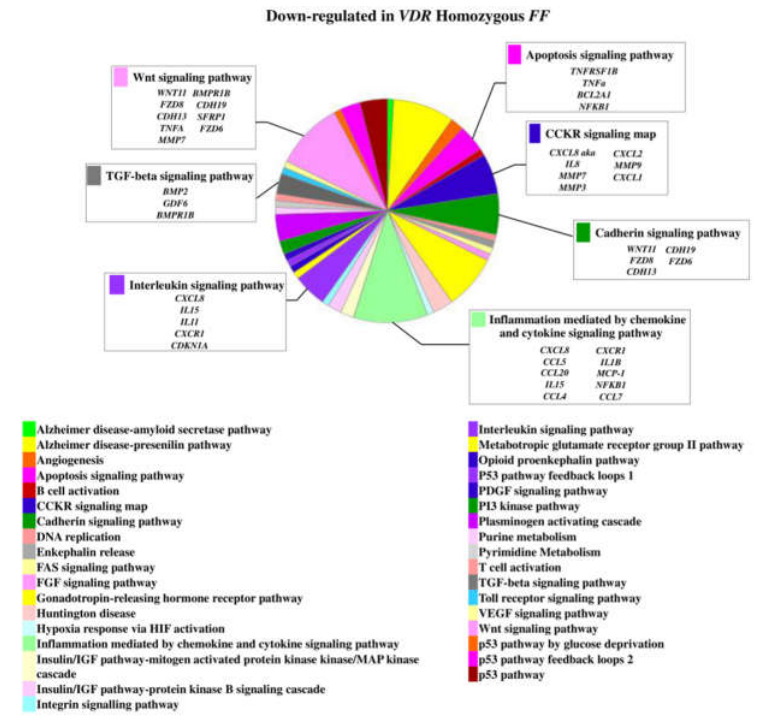
Figure 3. Upregulated genes and related pathways in heterozygous Ff disc cells. Pie chart obtained by Panther.